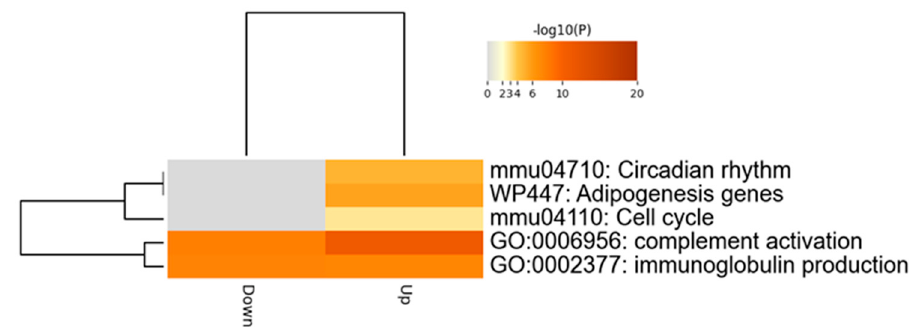
Figure 3. Enrichment analysis using Metascape.